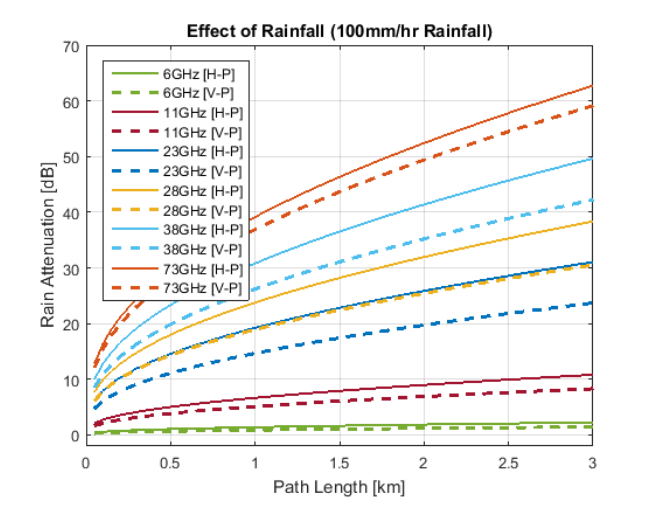
Fig 34. Effect of rainfall (3 km, 100 mm/hr) The fig. 35 below will visualize the amount of rain attenuation on different carrier frequencies for a rain rate of 250 mm/hr for a 3 km Tx-Rx separation distance.